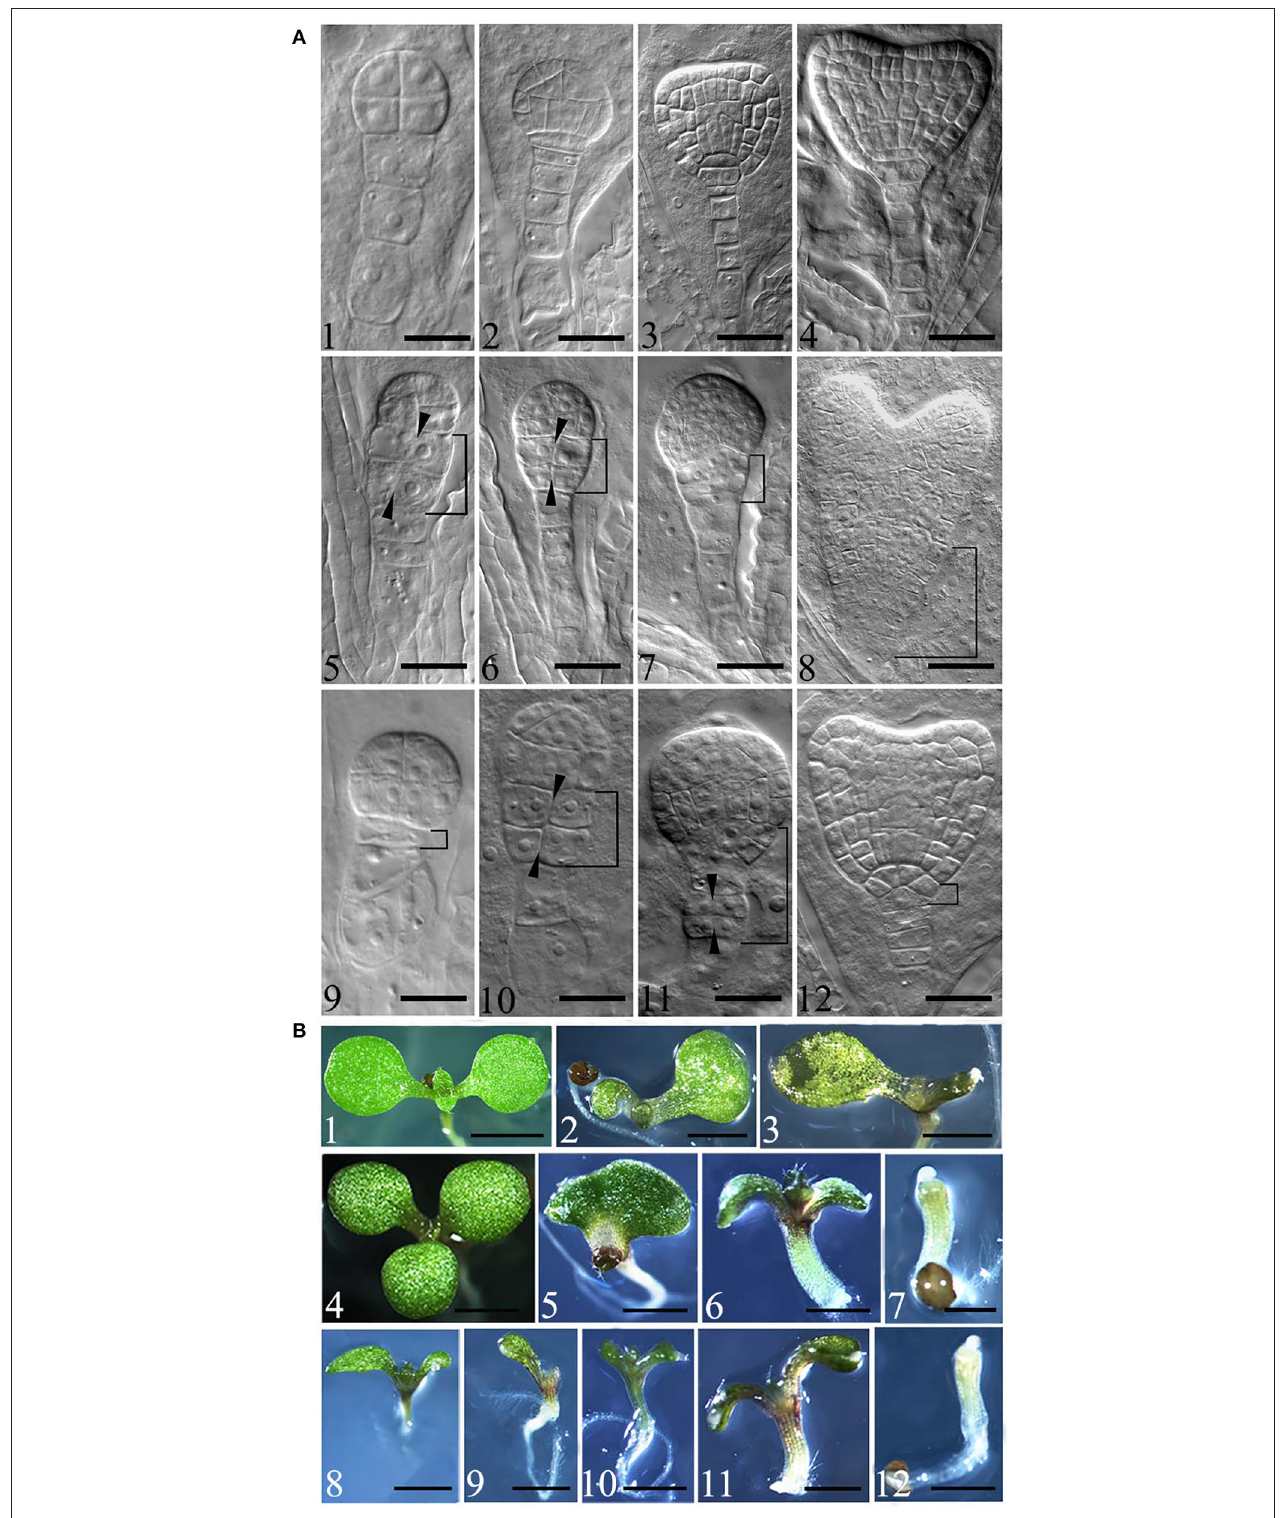
FIGURE 2 | Mutation of eIF4E1 induces developmental defects in embryo and seedlings. (A) Embryo defects in eif4e1 mutants. Embryos at 8-cell to heart stages from wild type (A1–4), eif4e1-1 (A5–8), and eif4e1-2 (A9–12). The black arrowheads show the position of the aberrant cell division plate. The bracketed area indicates cell division defects region. (B) Seedling phenotypes of eif4e1 mutants. Seven-day-old seedlings of wild type (B1), eif4e1-1 (B2–7), and eif4e1-2 (B8–12) mutants. Scale bars: (A) 50 µ m; (B) 2mm.